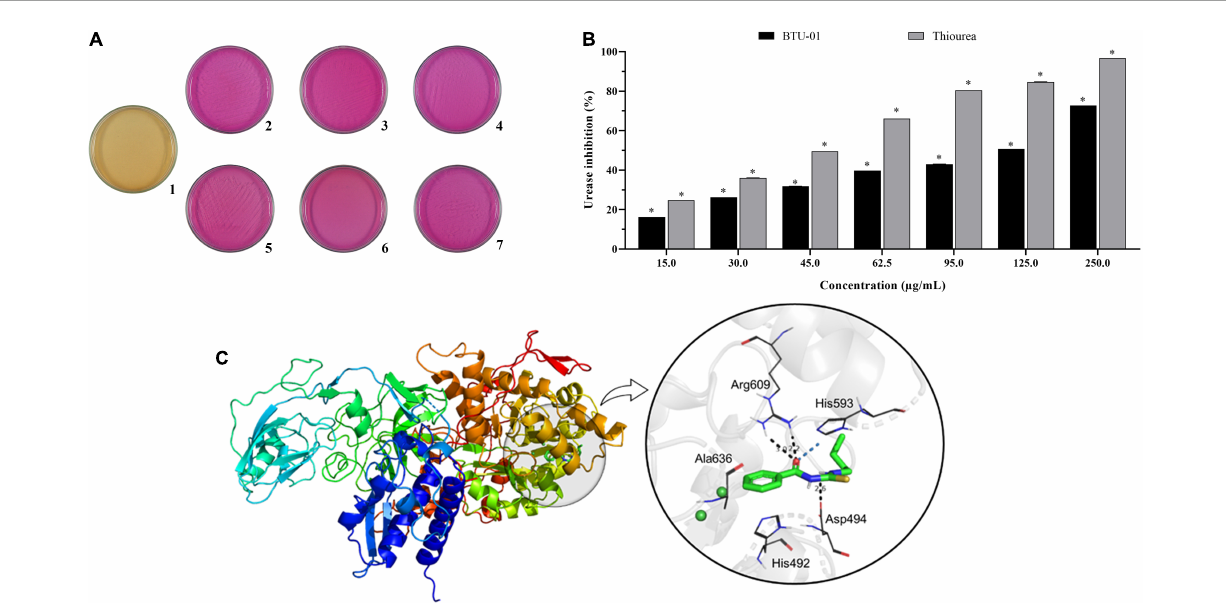
FIGURE1 Effect N -(butylcarbamothioyl) benzamide (BTU-01) on urease activity of Cryptococcus neoformans . (A) Growth of C. neoformans in Christensen’s urea medium. (1) Absence of urease activity–negative control; (2) C. neoformans ATCC 34872; (3): C. neoformans ATCC 66031; (4): C. neoformans 1172; (5): C. neoformans 90889; (6): C. neoformans CN12; (7): C. neoformans CN01. (B) Percentage inhibition of BTU-01 on urease activity. Enzyme activity was evaluated by the indophenol method, and thiourea was used as urease inhibitor control. Values are mean ± standard deviation of three experiments. Asterisks indicate a significant inhibition activity in treated urease compared to untreated control ( ∗ p < 0.05). (C) BTU-01 interaction complex with urease (PDB: 4H9M). Ligand is in green carbon sticks and the amino acid residues are in gray carbon sticks. The other elements follow their colors: N: blue; O: red; H: white, and S: yellow. Conventional H-bonding is shown as black dots and unconventional H-bonding in marine